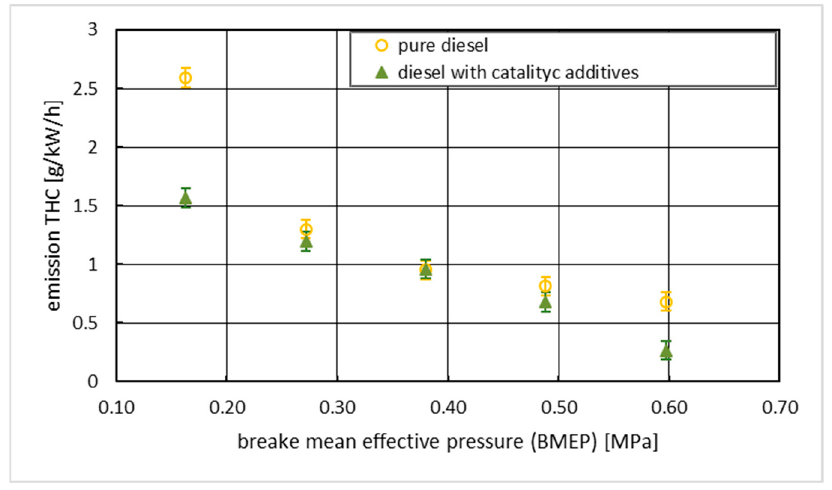
Figure 7. THC emission vs. brake mean effective pressure at an engine speed of 2000 rpm.